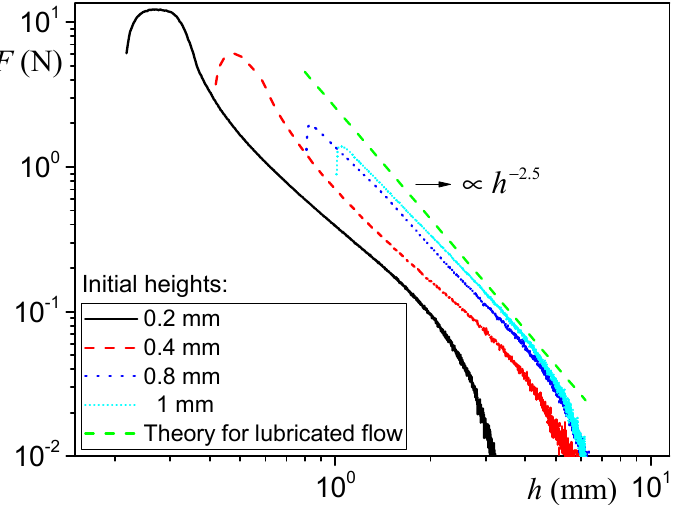
Figure 4. Force vs. distance during a traction experiment for an emulsion (82%) (yield stress of 40 Pa) for different initial aspect ratios (corresponding to first point of curves on the left) ( Ω = 3 mL). The dashed line is the lubrication model (see text).